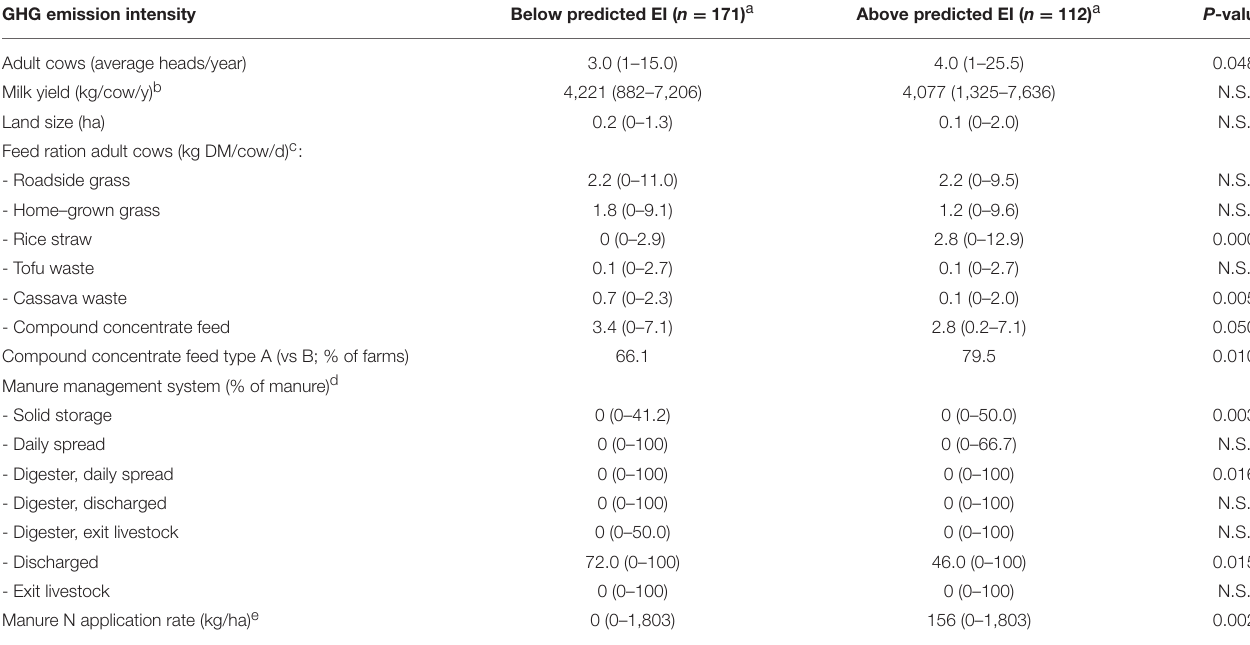
TABLE 4 | Differences [median (range); P < 0.05] between farms with a greenhouse gas (GHG) emission intensity below and above their predicted emission intensity based on milk yield. GHG emission